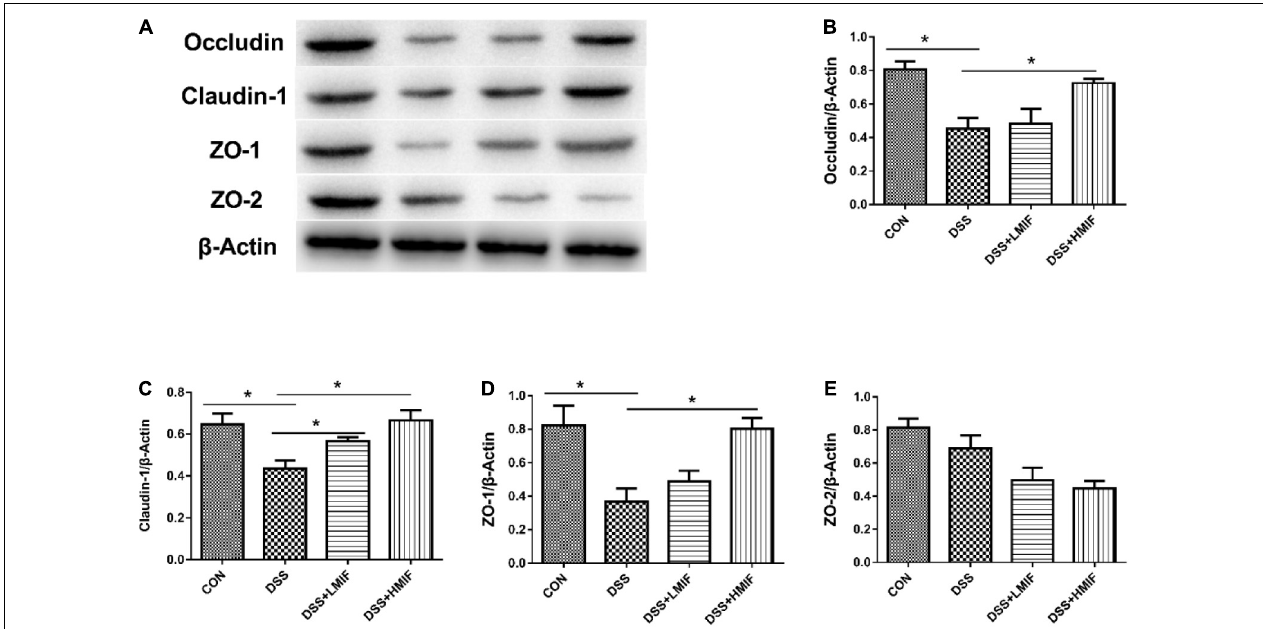
FIGURE 2 | Effects of Morchella importuna flavones on the abundances of the colonic tight junction proteins in dextran sulfate sodium (DSS)-challenged mice. (A) Representative Western blot picture; (B) occludin; (C) claudin-1; (D) zonula occludens-1 (ZO-1); (E) ZO-2. CON, control; DSS, DSS treatment; LMIF, DSS treatment + 100 mg/kg fruiting bodies of Morchella importuna (MIF); HMIF, DSS treatment + 200 mg/kg MIF. * p < 0.05.